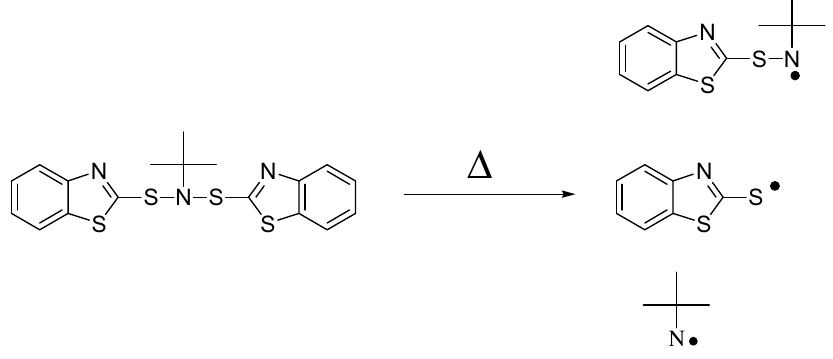
Figure 5. Possible radicals generated by thermal decomposition of IVa.